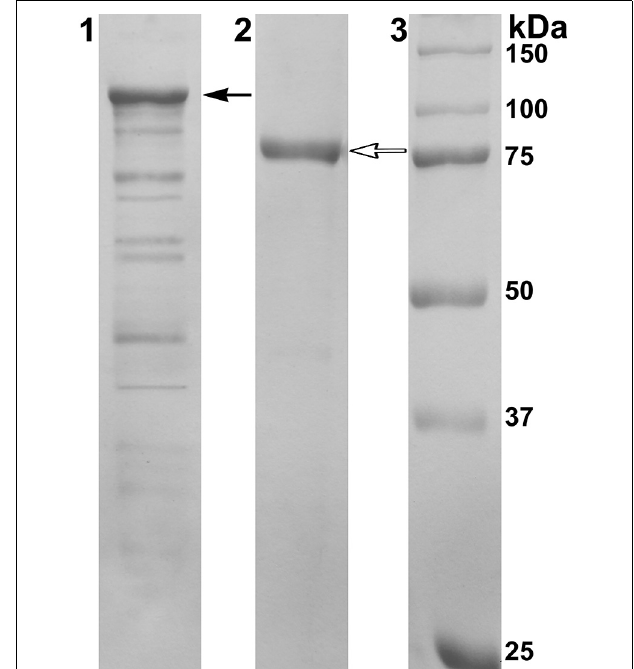
FIGURE 2 | Results of 12.5% SDS-PAGE electrophoresis. Line 1: Cell extract of E. coli Rosetta(DE3)/40Gal; Line 2: α - Ps Gal after final purification step; Line 3: MW-standards. Filled arrow indicates the band corresponding to the chimeric protein with DsbC overhang (112.5kDa); empty arrow indicates the band corresponding to the mature protein after enterokinase treatment (80kDa).